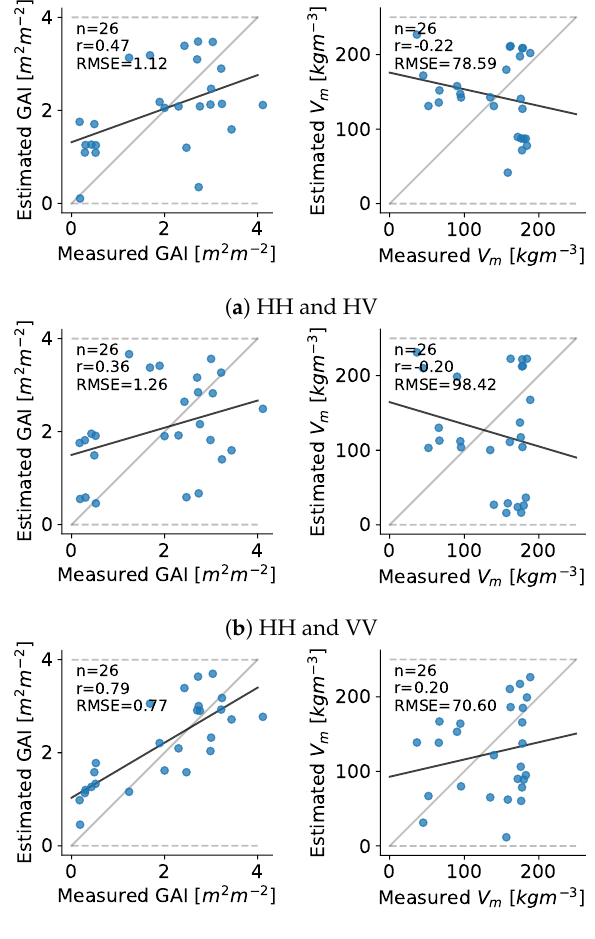
Figure 13. Results from the LOOCV for the simultaneous retrieval of maize GAI and volumetric surface soil moisture, V m , from ( a ) HH and HV; ( b ) HH and VV; ( c ) HV and VV polarization pairs, using a random forest regressor (RFR).